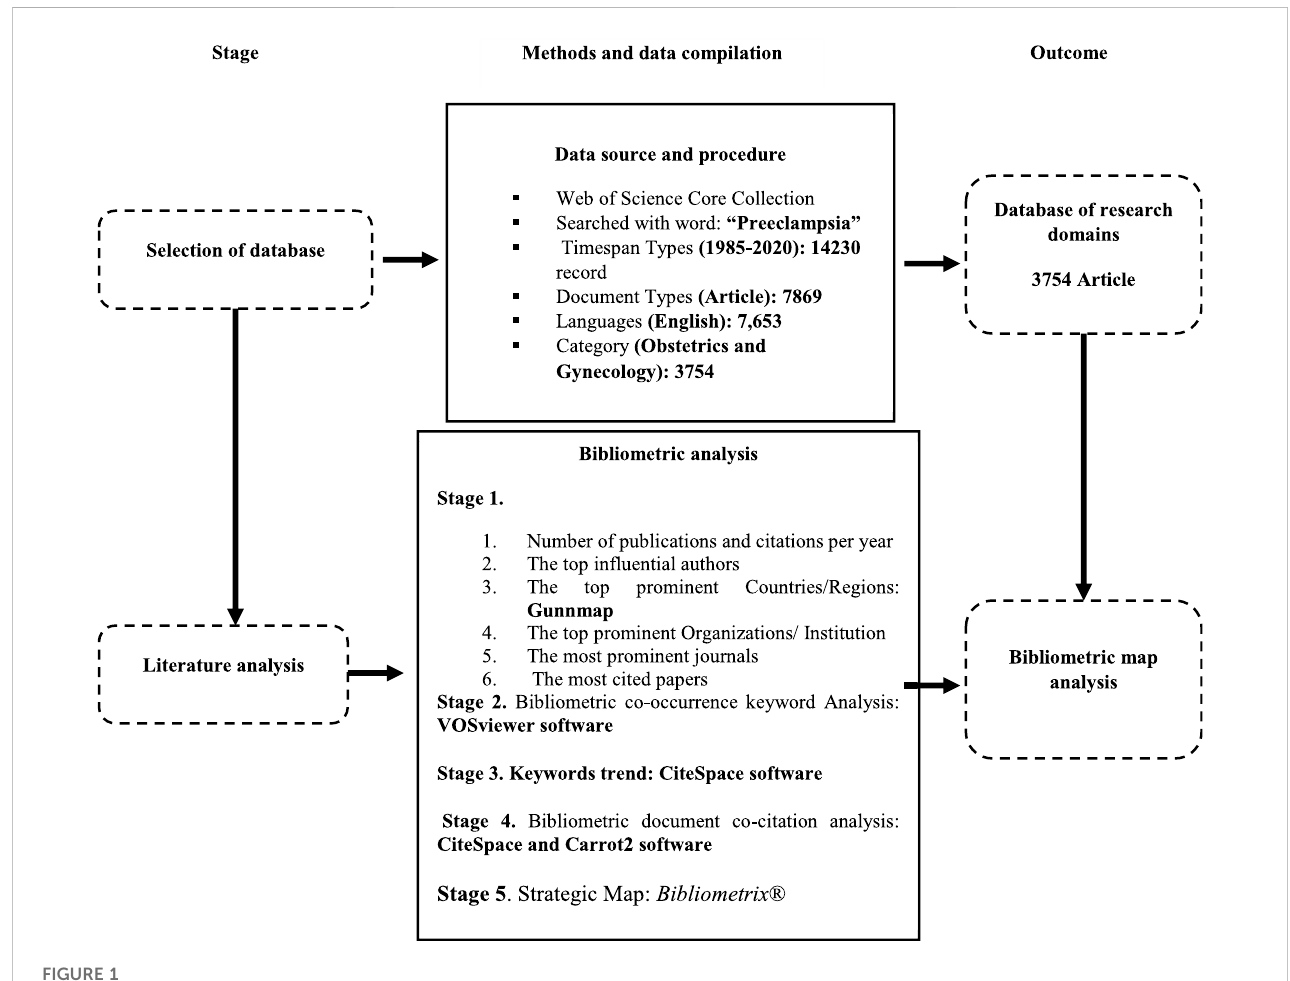
FIGURE 1 Methodological approach (Author ’ s